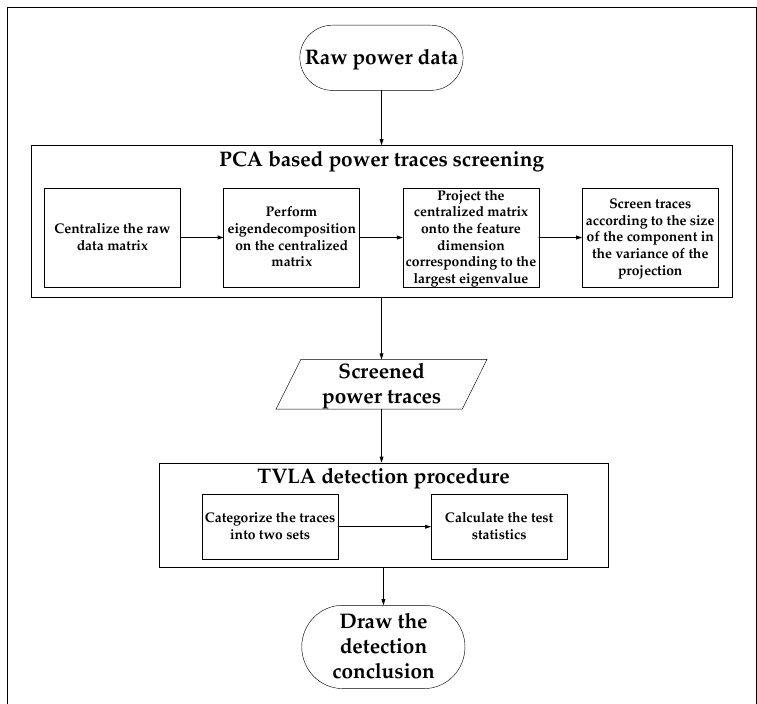
Figure 1. PCA-TVLA-based leakage detection